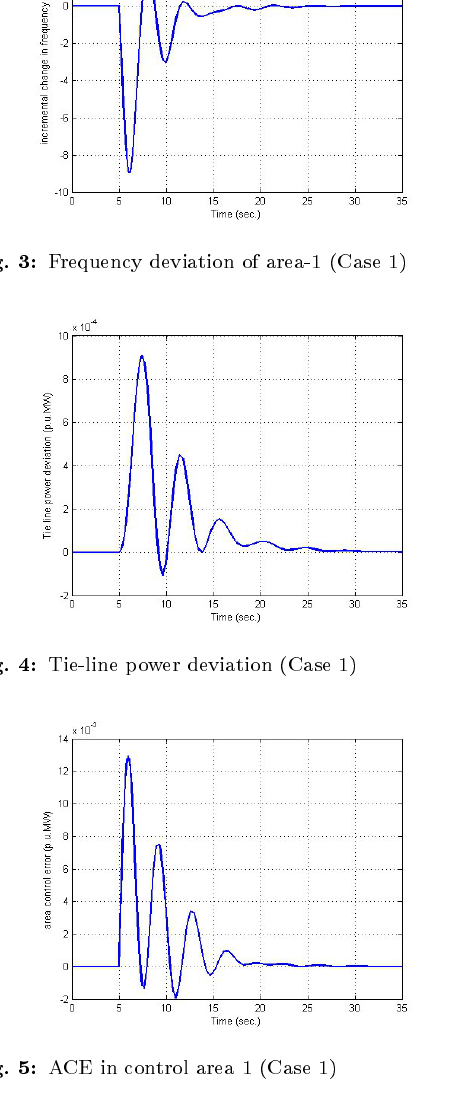
observed that the frequency deviation, the tie- line power deviation and the area control error converge to zero. The simulation results indi- cate that the controller given in [10], [35] results in considerably larger oscillating overshoots and larger transient frequency deviation in both area 1 and area 2, comparing with the results from the proposed observer output-feedback